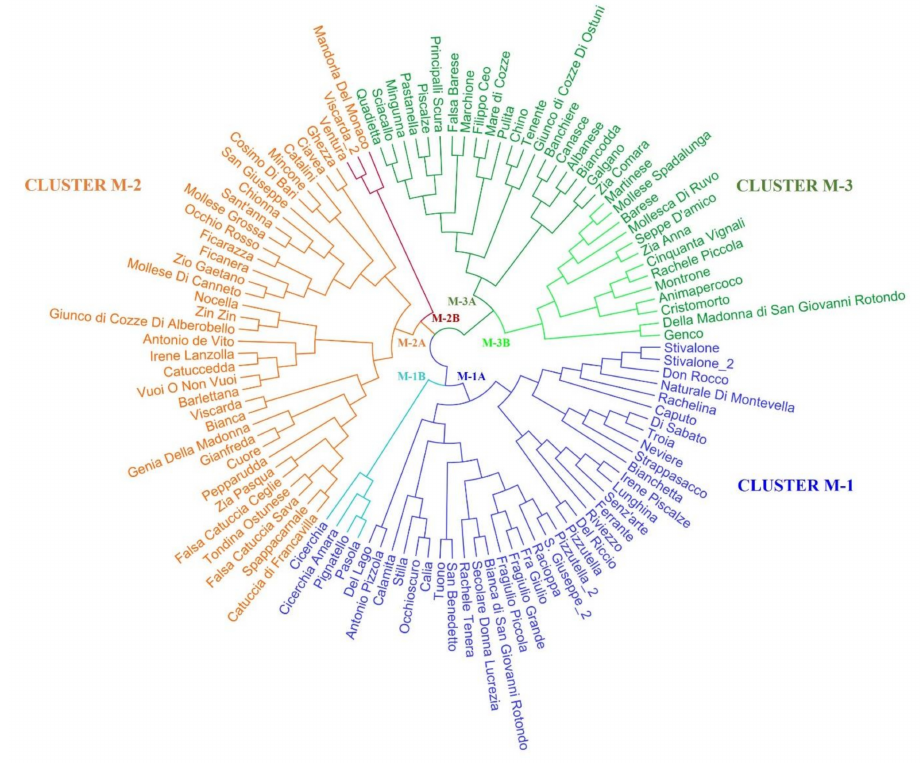
Figure 7. Morphological dendrogram generated by the neighbor-joining clustering method using all 17 phenotypic descriptors on a subset of 109 almond